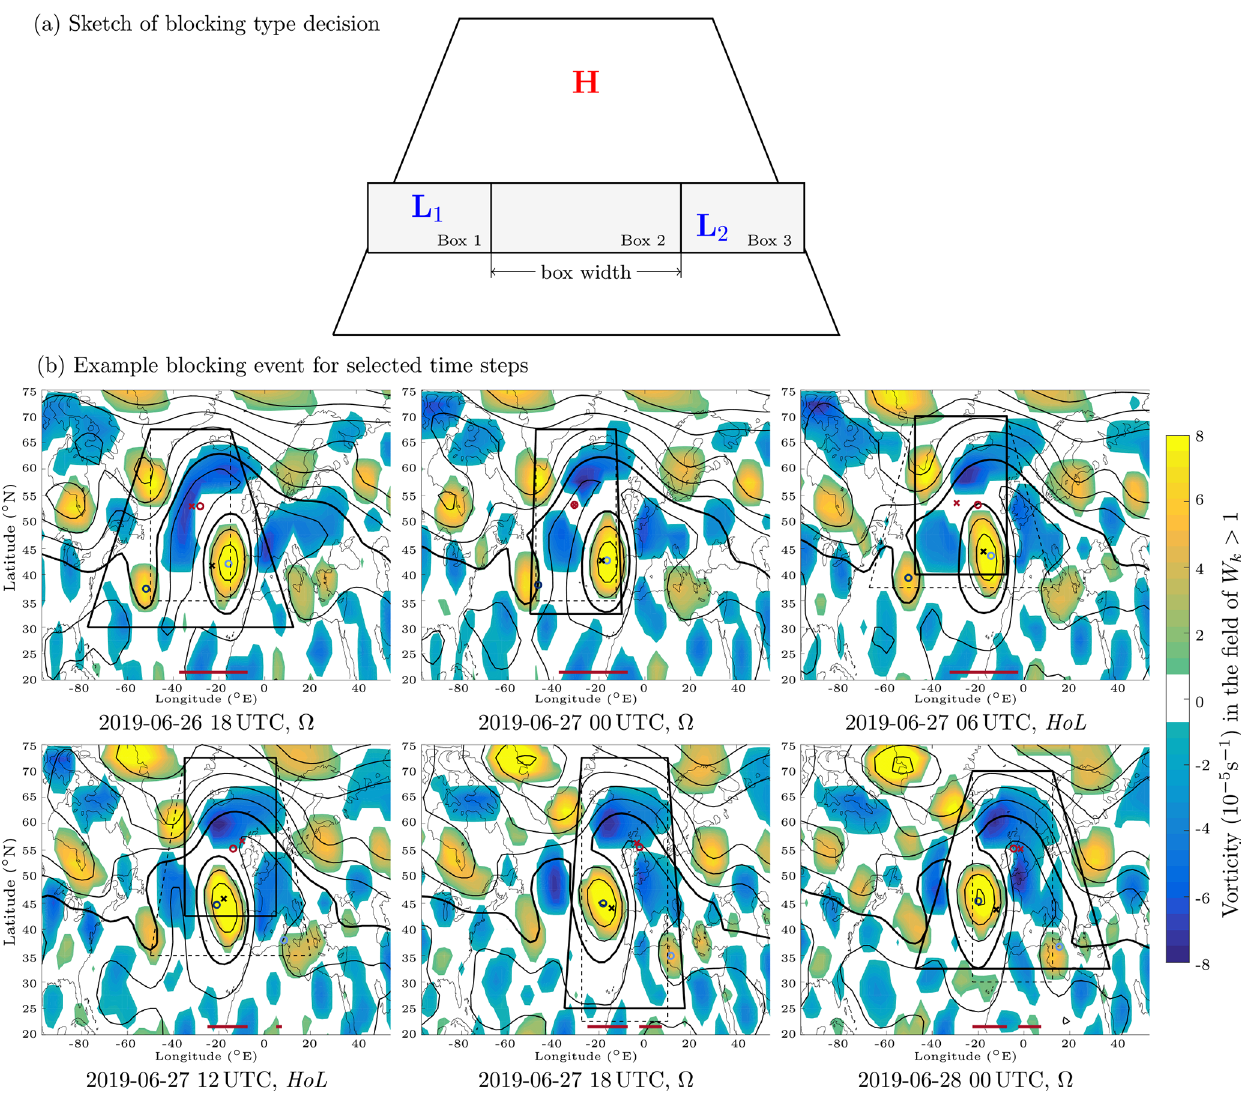
Figure 3. (a) Schematic representation of the blocking type decision based on the trapezoid method. The positive relative vorticity is calcu- lated for all three boxes, which lie on the mean latitude of the low-pressure areas ( L 1 , L 2 ). Depending on the magnitude of the mean vorticity in these three boxes, the decision between high-over-low and omega is made. (b) An example blocking event, observed from 26 June 2019 at 18:00:00UTC to 28 June 2019 at 00:00:00UTC, is plotted for six time steps that include a transition between omega and high-over-low blocking states. Shaded areas represent the identified vortex field ( W k > 1), which is colored by relative vorticity (in 10 − 5 s − 1 ; blue: anticy- clonic; yellow: cyclonic). Black contours are isolines of geopotential height in 8dm intervals (the thick black contour is the 584dm isoline). The outline of the trapezoid or box is given for each time step; solid shapes represent the identified shape; circles are the circulation centroids of the identified high (red) and low(s) (blue) for the omega pattern. In the same way, crosses are used for a high-over-low pattern. The red bars at the bottom of the figures show the identified IBLs from Step 1. The figures were plotted with the help of Matlab (2016), and coastlines were plotted with the built-in MATLAB file coast.mat . The full time series is given in the Supplement; see also steps 2 and